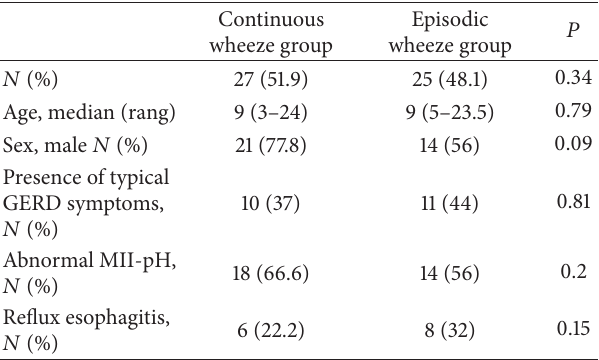
Table 1: Demographic data of the studied